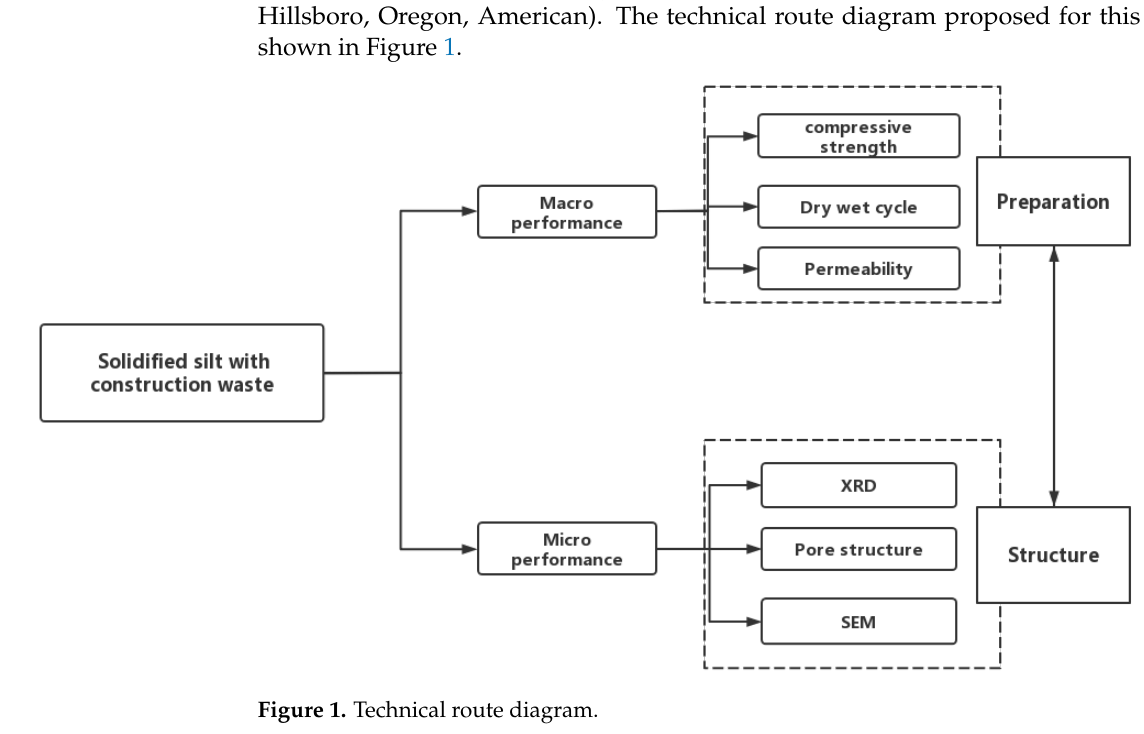
Figure 1. Technical route diagram.